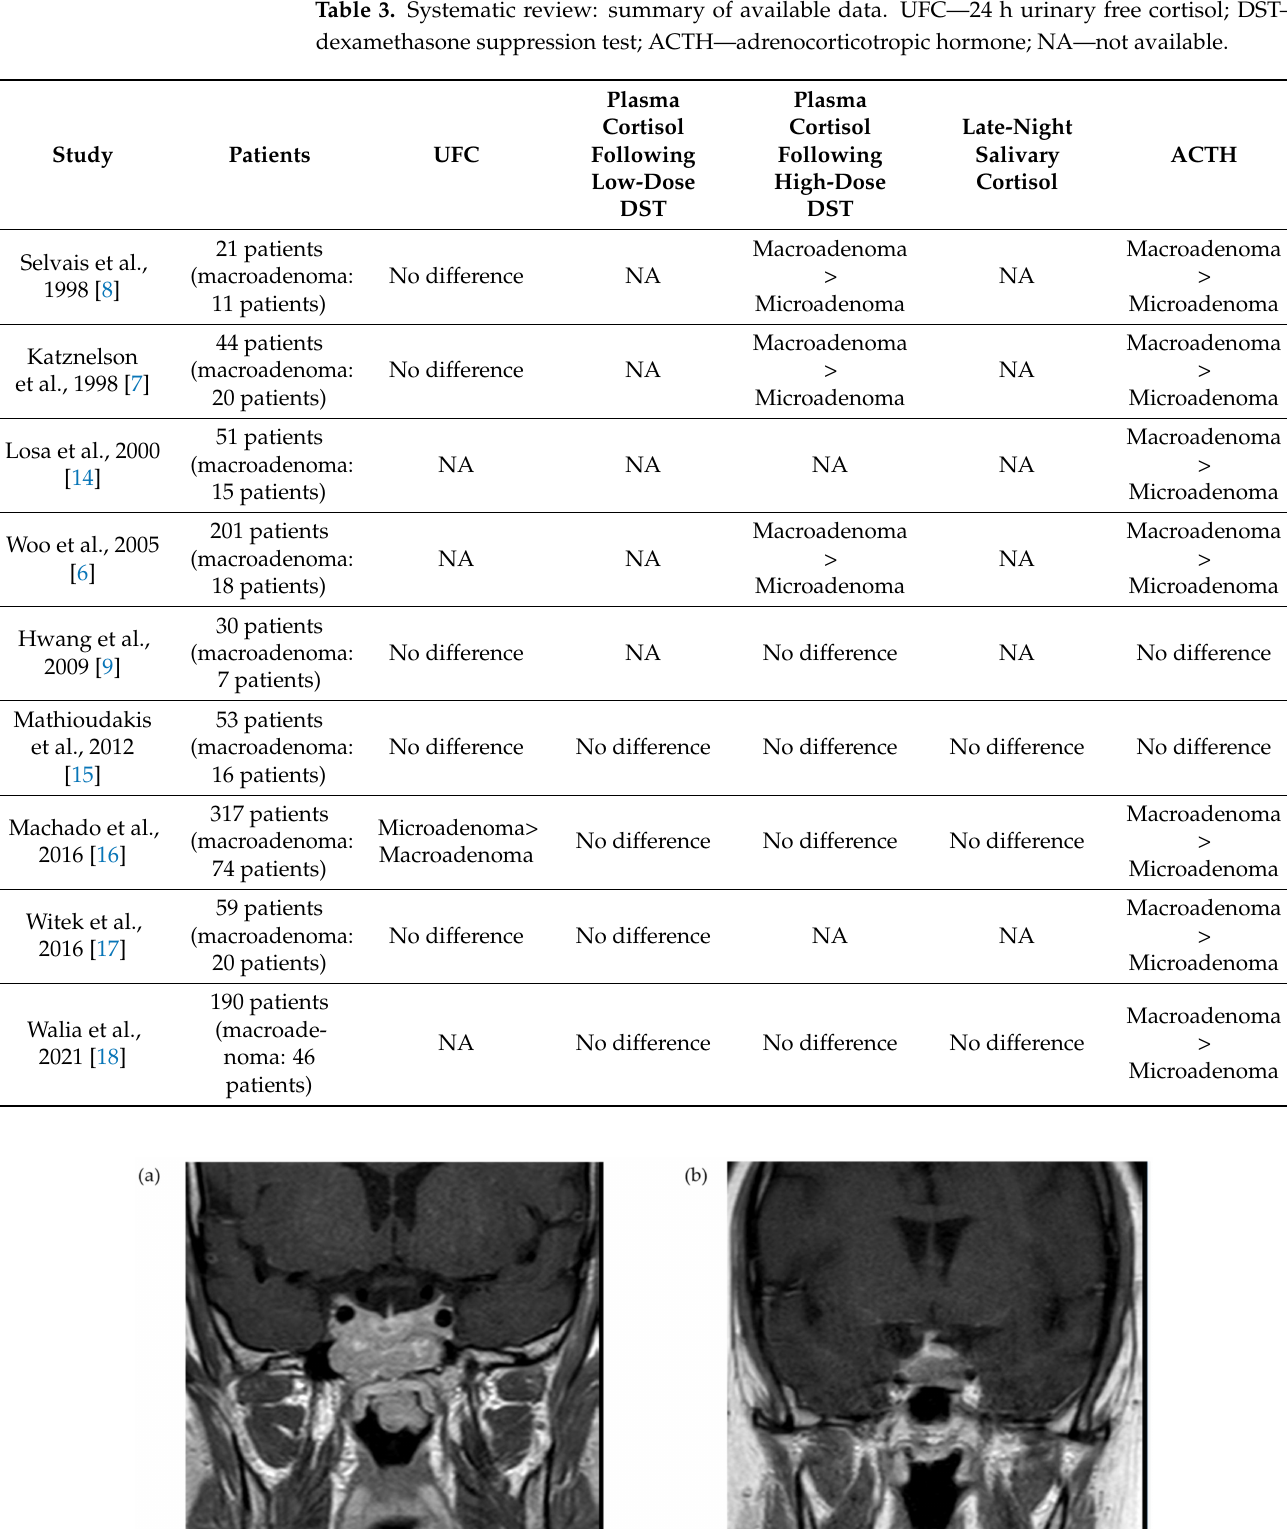
Table 3. Systematic review: summary of available data. UFC—24 h urinary free cortisol; DST—